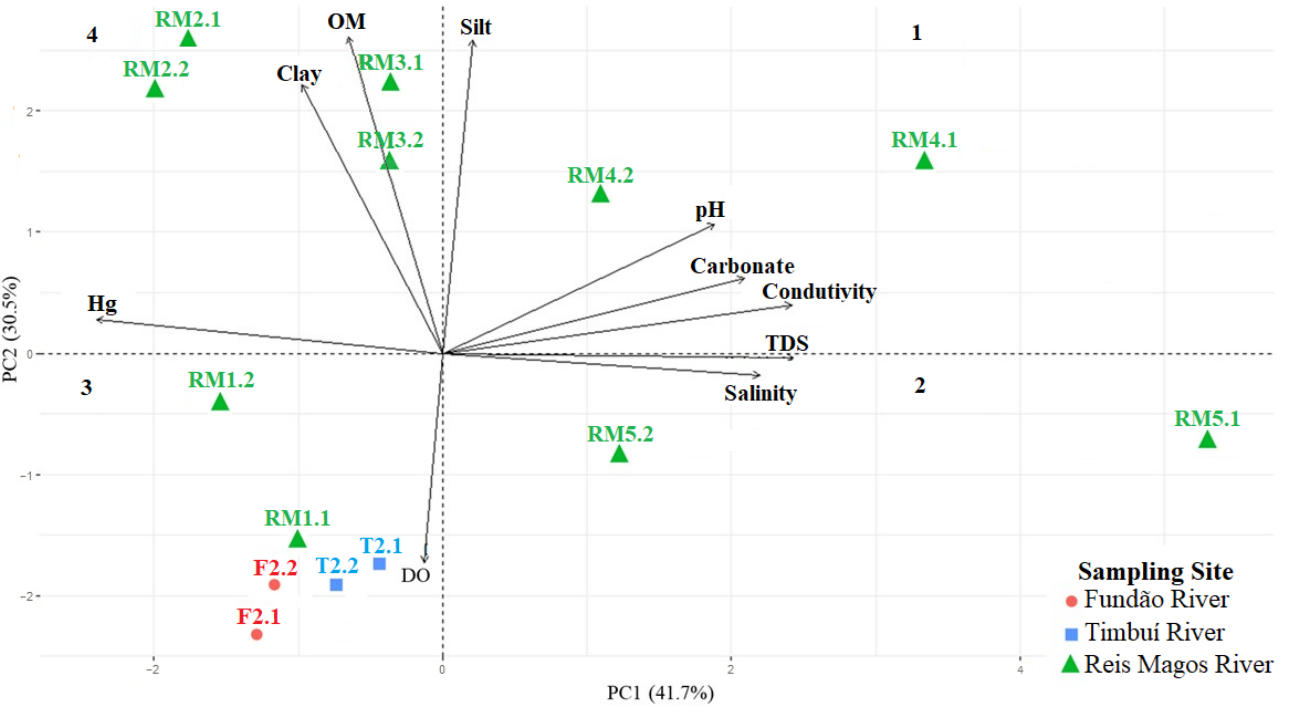
Figure 4. Principal component analysis with physical-chemical characteristics of sediment and water and Hg contents in sediment samples.